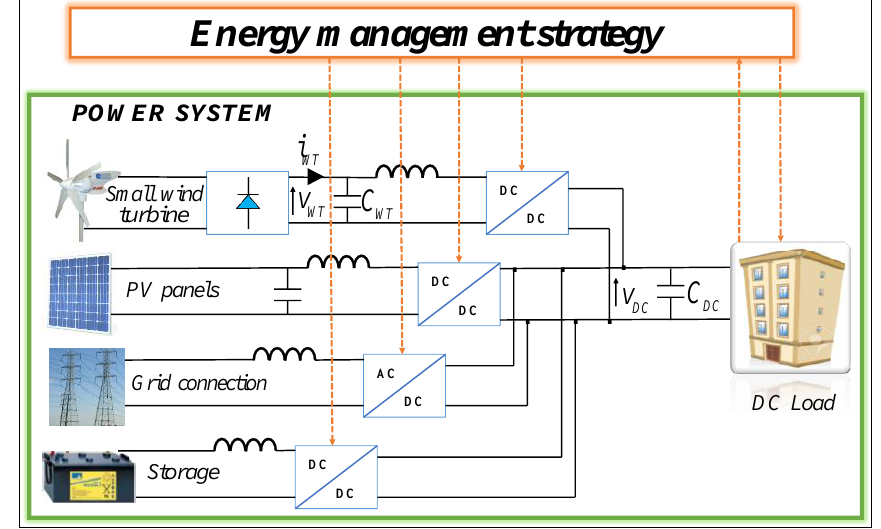
Figure 1. The microgrid (MG) overview.